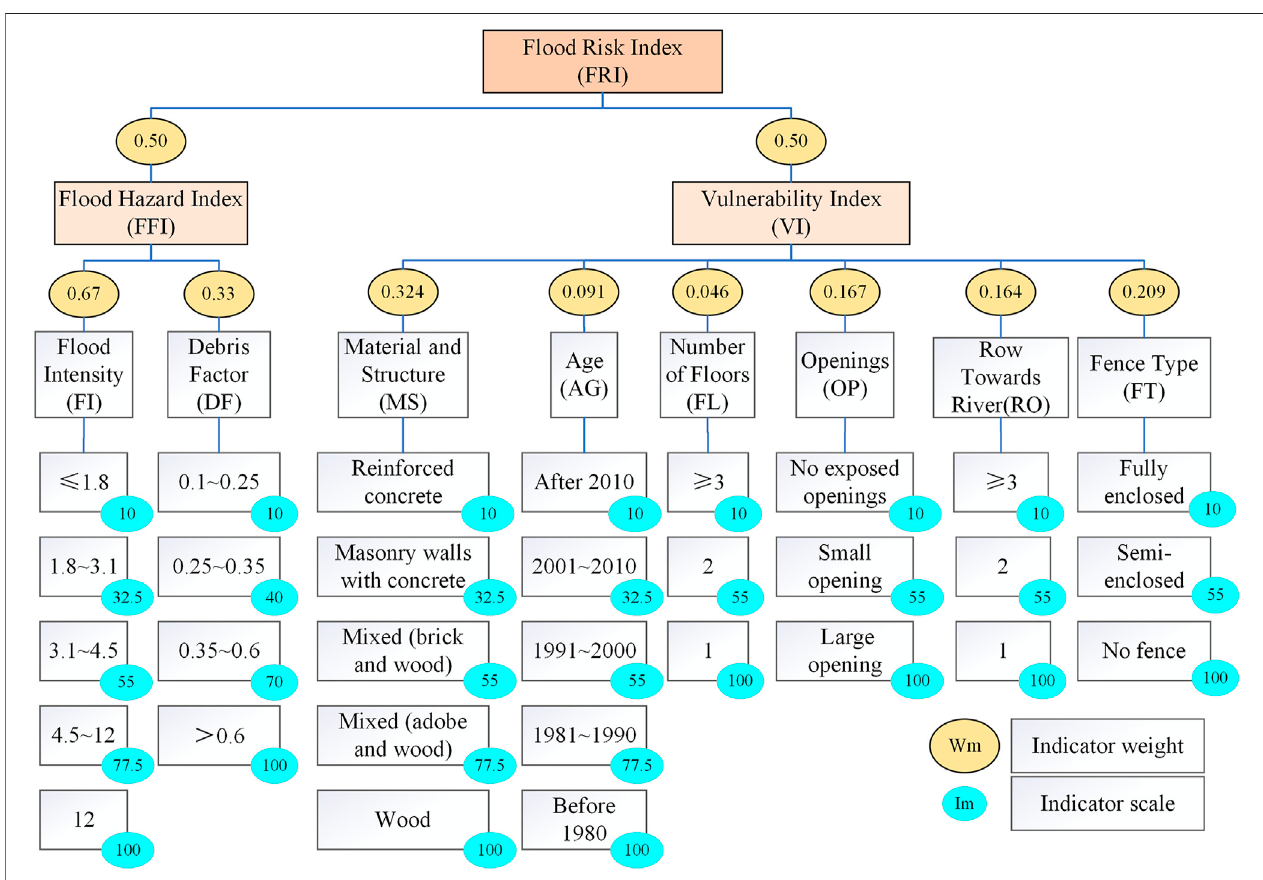
FIGURE 7 | Computation framework for fl ood risk index (Adapted from Kappes et al., 2012)